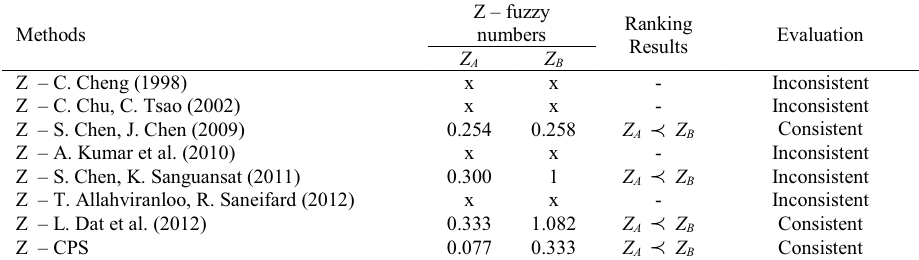
Table 3.Comparative results using Z – fuzzy numbers of Case 3.